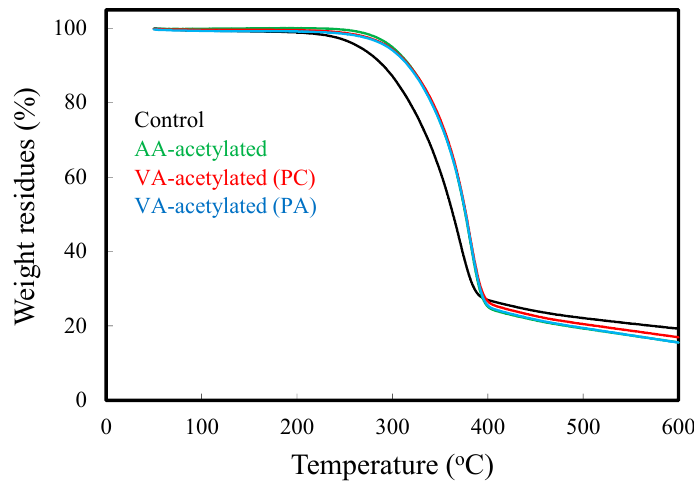
Figure 6. Thermogravimetric curves of unmodified slicewood, AA-acetylated slicewood (WPG 18%), and VA-acetylated slicewood (cWPG 18%) with PC and PA.